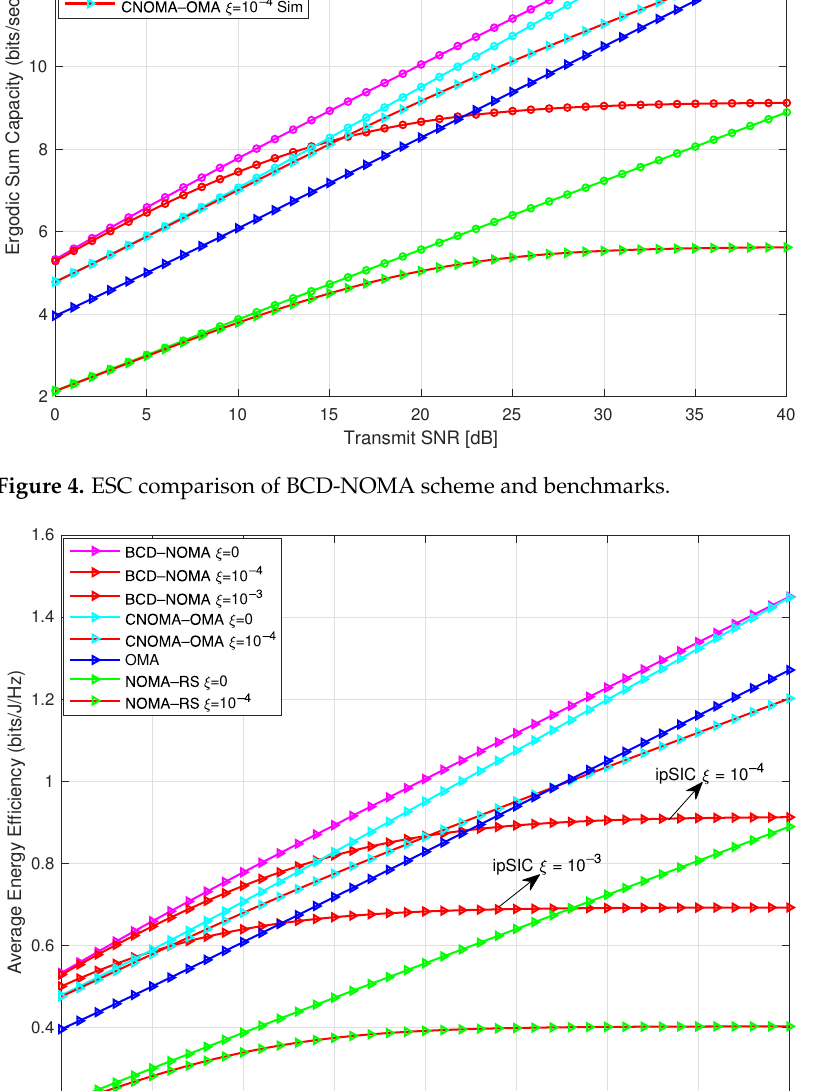
Figure 5. Energy efficiency comparison of BCD-NOMA scheme and benchmarks, where P S P r = 10